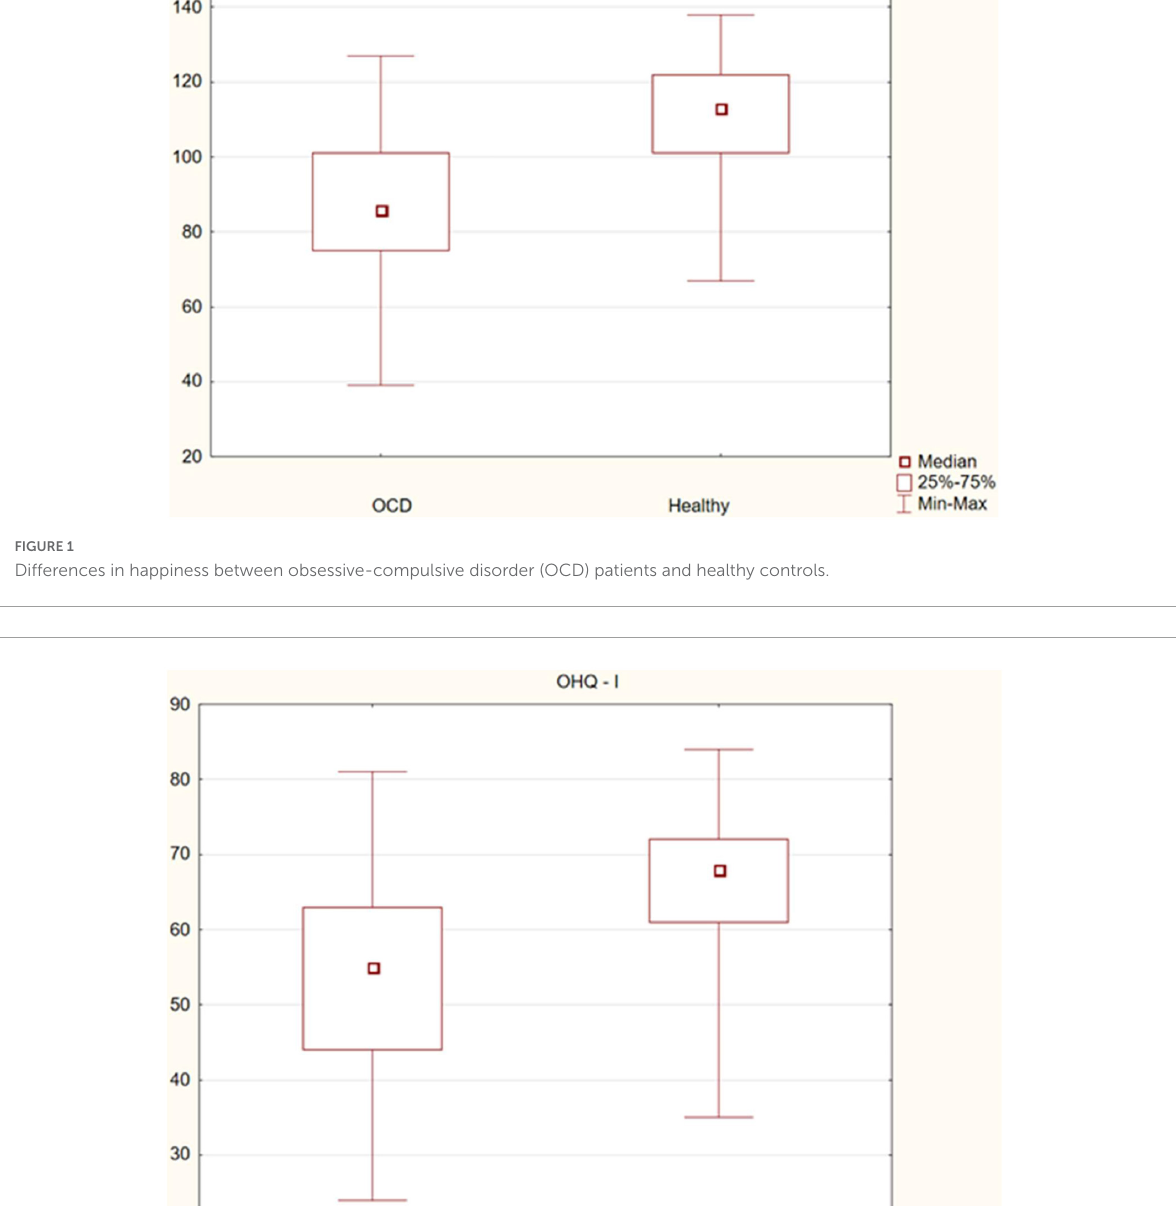
control group (27 vs. 12%). It should be assumed that loneliness was not a conscious choice of the affected person, but a consequence of